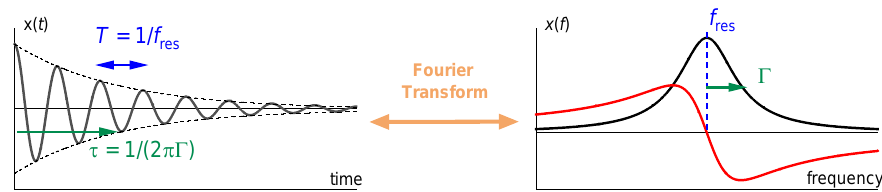
f x ( f ) x( t ) res T = 1/ f res Fourier Γ Transform τ = 1/(2 πΓ ) frequency time Figure 5. The time trace in ring-down and the resonance curve as a function of frequency are related to each other by a Fourier transform. The resonance parameters (mostly f res and Γ or D ) can be obtained from both sets of data. The precision is similar.